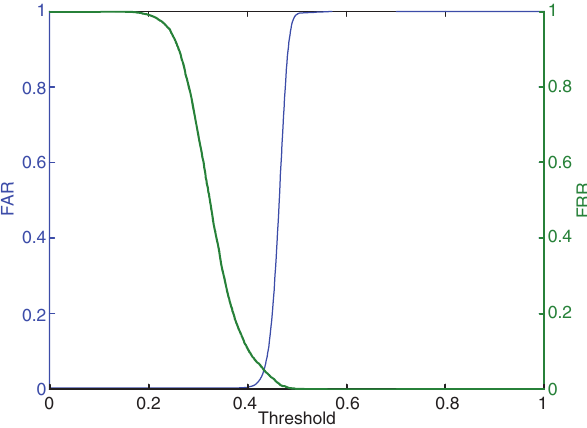
Figure 19. FAR versus the FRR for Different Values of the Threshold Using Cosine